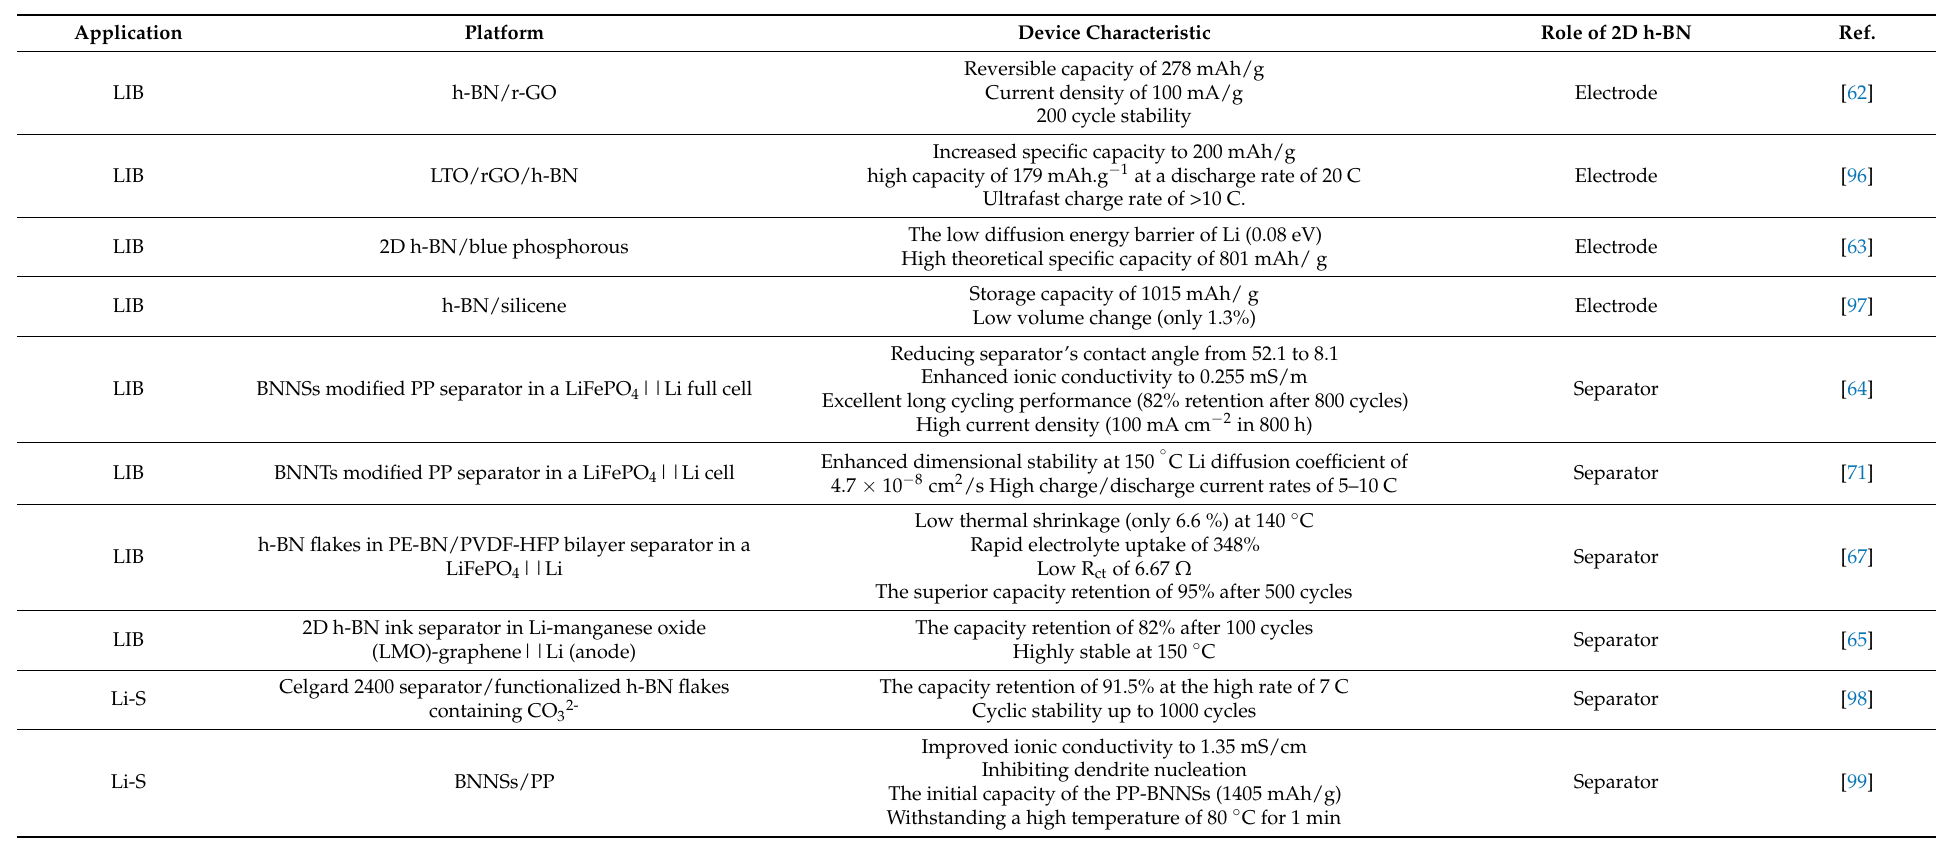
Table 2. Device performance of energy storage units (batteries and supercapacitors) based on 2D